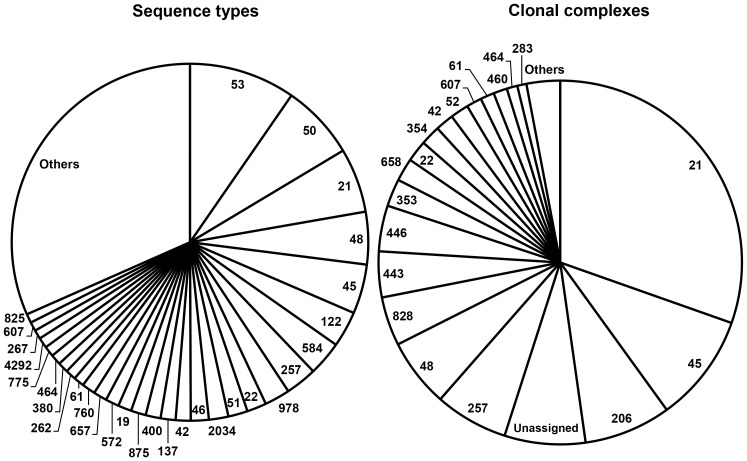
Human Campylobacter strains per clonal complex and sequence type assigned with MLST.The category ‘others’ includes clonal complexes and sequence types with less than five isolates.